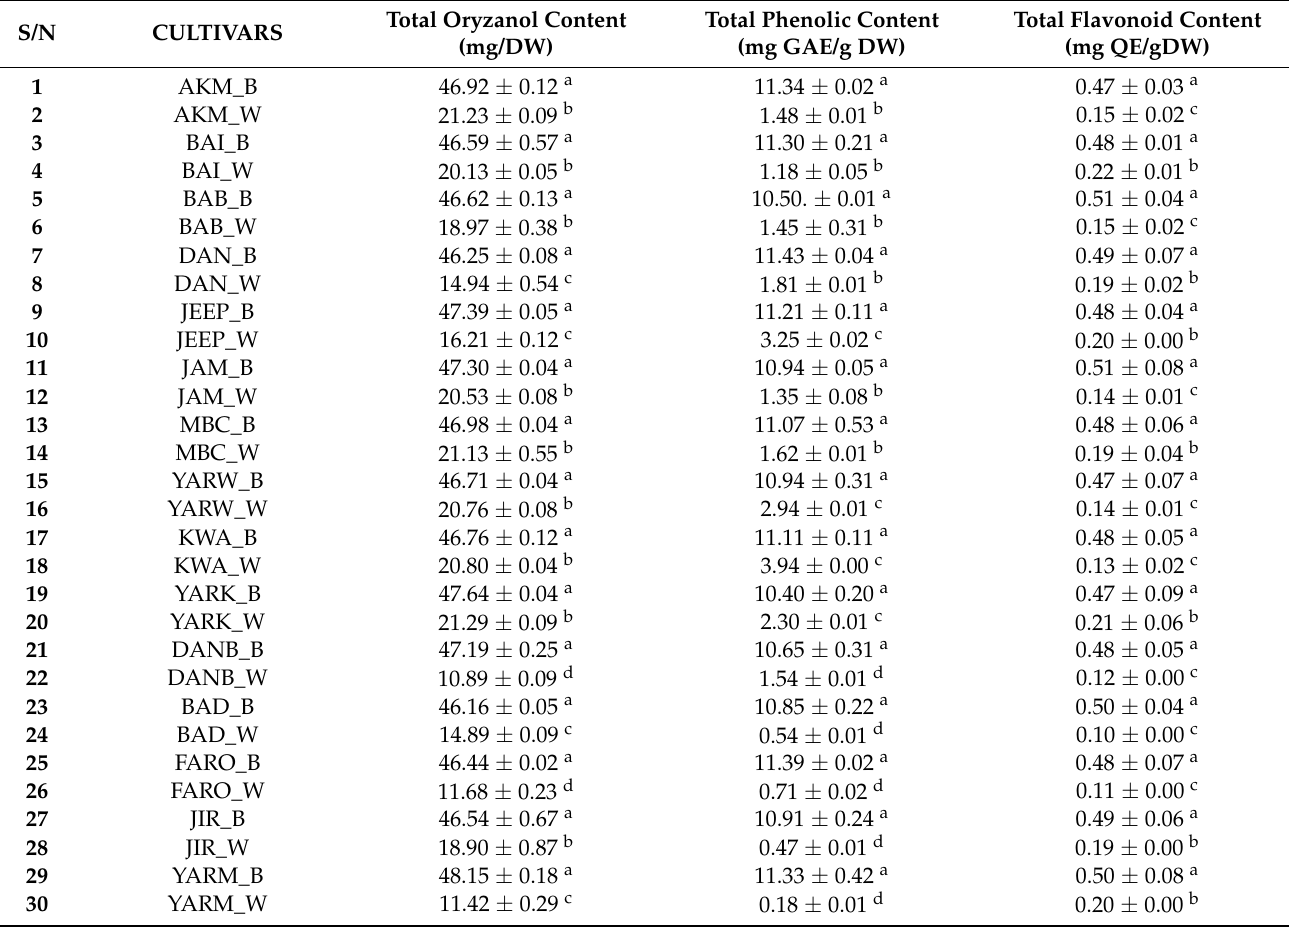
Table 2. Bioactive composition of rice